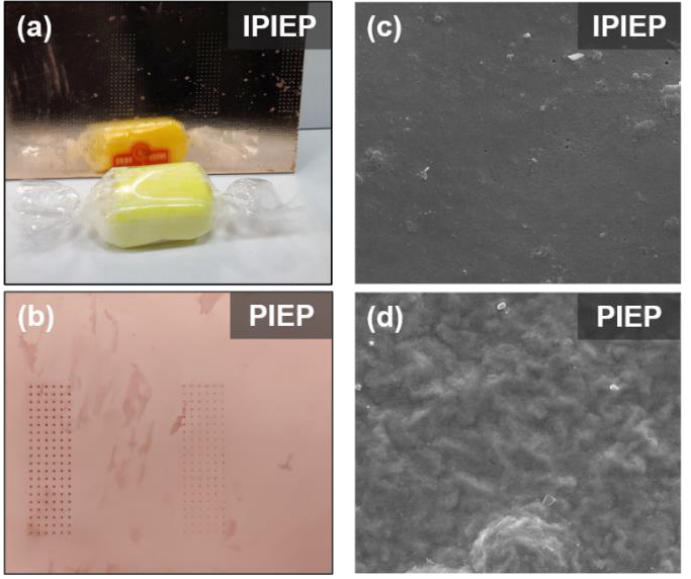
Figure 4. The surface appearance of the deposited copper was obtained from IPIEP ( a ) and PIEP ( b ). FE-SEM images of copper deposits obtained in the electrolyte containing: ( c ) IPIEP; ( d ) PIEP.